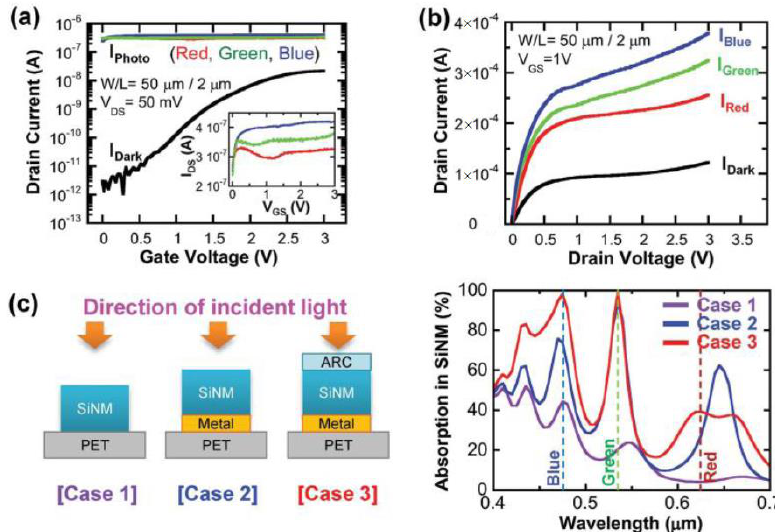
Figure 17. ( a ) Drain current-gate voltage characteristics ( I DS - V GS ) at V DS = 0 V. The inset shows the magnified plot of photo currents. ( b ) Drain current-drain voltage characteristics ( I DS - V GS ) under dark and illumination with various light sources (red, green and blue) onto flexible phototransistors. The I DS - V GS curve under V GS = 1 V for the photo-to-dark current ratio shows as high as ≈1 × 10 5 . ( c ) (Left) Three layer structures used to simulate the light absorption of Si NM, (right) and their corresponding simulated absorption of Si NM: (i) without any layers; (ii) with the metal reflector underneath the Si NM; (iii) with the metal reflector underneath the Si NM and SU-8 ARC layer on the top of Si NM, respectively. The dashed line denotes blue (473 nm), green (532 nm) and red (632 nm) wavelengths (reprinted from [25]).